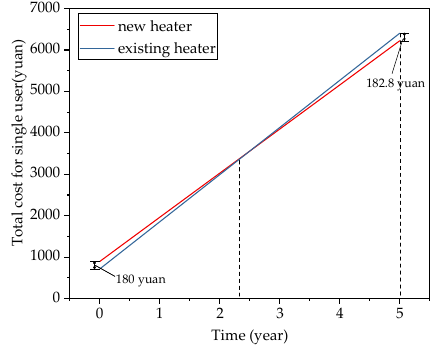
Figure 10. Total cost for single user.